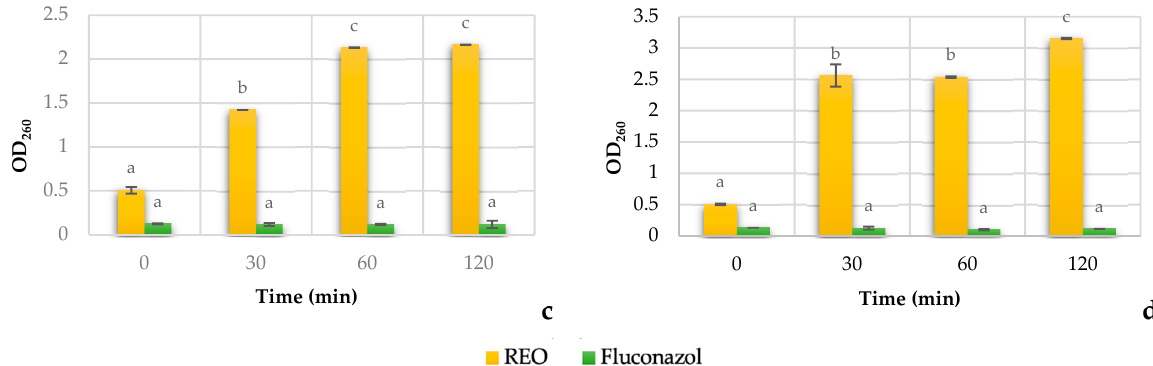
Figure 3. Effect of REO and Fluconazole on the 260 nm absorbing cell constituents release with the time. Release cell concentration of C. Tropicalis ORL21 ( a ), of C. Tropicalis ORL20 ( b ), of C. albicans ORL08 ( c ), and of C. albicans ORL03 ( d ) with the treatment at different time. The results are expressed as the absorbance of the sample (treated)–the absorbance of the control (no treated). Results are according to ANOVA test mean values and intervals based on Tukey test for time with 95%. Different lowercase letters (a, b, c) indicate significant differences between times according to the Tukey test in a confidence interval of 95%.